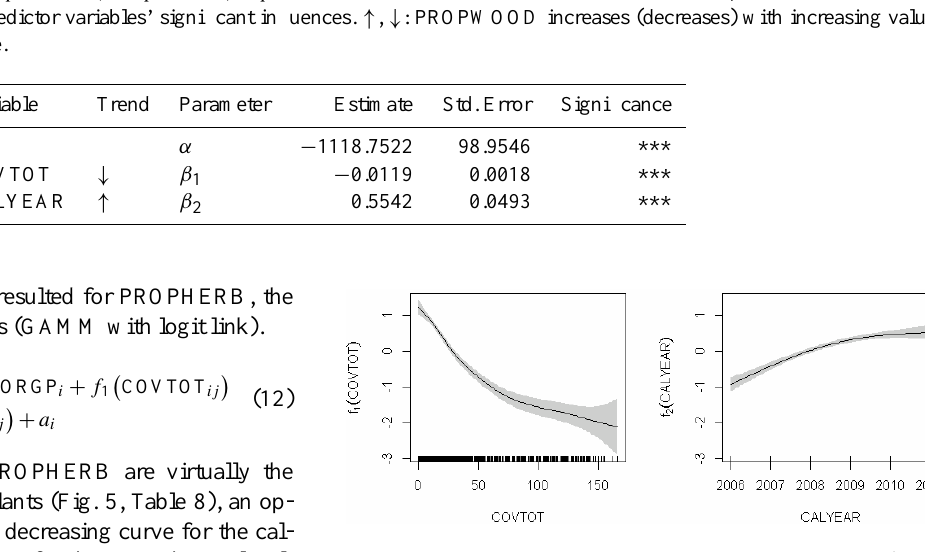
Figure 6 1103 Fig. 6. Nonlinear effects of the total degree of coverage (COV- TOT), and calendar year (CALYEAR), on the proportion of grasses (PROPGRASS) (see Eq. 13). Shaded: 95%-confidence